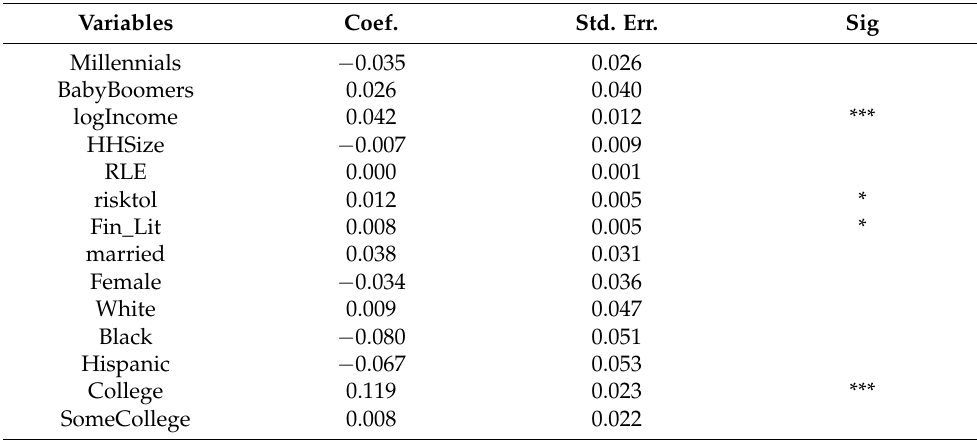
Table A7. Retirement Preparedness Estimation for Simulated 80–20 Allocation. Variables Coef. Std. Err.